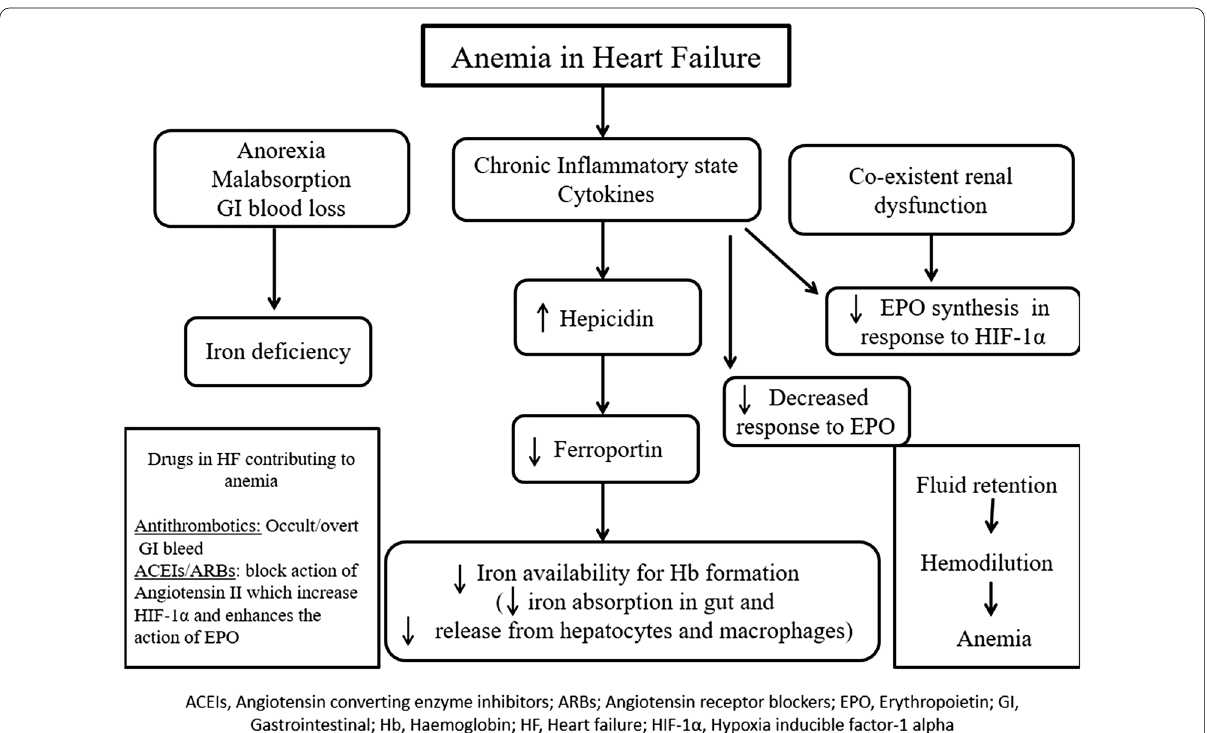
Fig. 1 Etiology of anemia in heart